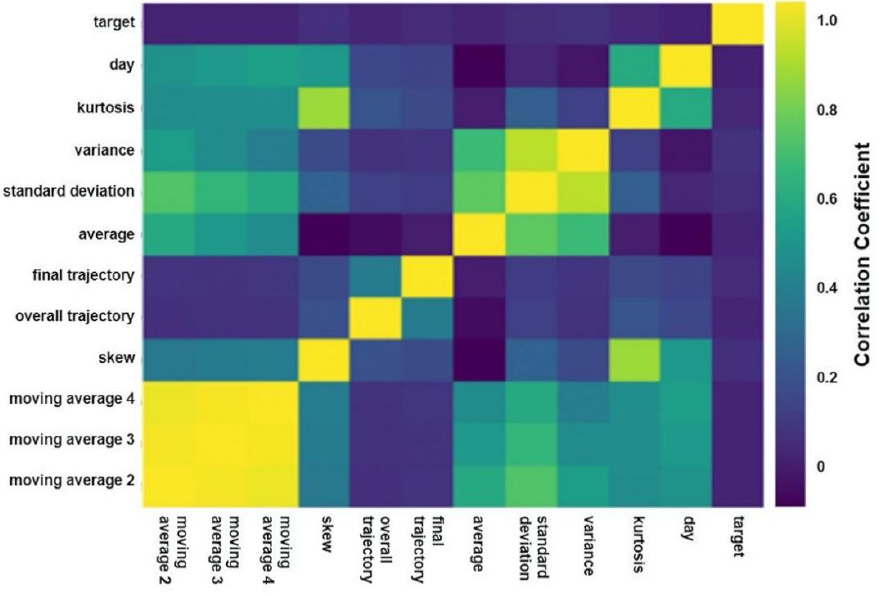
Figure 5. Correlation Matrix of Features.